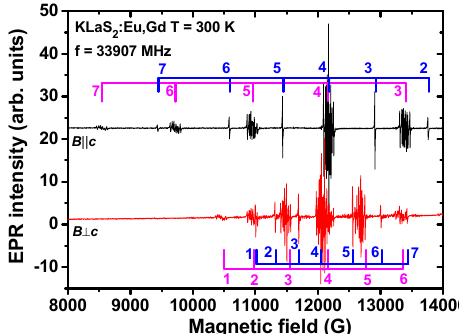
Figure 10. Electron paramagnetic resonance (EPR) spectra measured in KLaS 2 :Eu single crystal at two magnetic field directions, B || c and B c . The pink combs indicate transitions corresponding to Eu 2+ (each transition is characterized by a pronounced hyperfine structure (HFS)) and the blue combs indicate transitions corresponding to Gd 3+ (single narrow lines). Numbers are assigned to particular transitions; 1: − 7/2 − 5/2, 2: − 5/2 − 3/2, 3: − 3/2 − 1/2, 4: − 1/2 +1/2, 5: +1/2 +3/2, 6: +3/2 +5/2, 7: +5/2 +7/2.